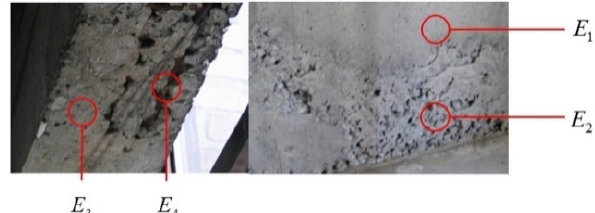
ff erent elastic modulus in di ff erent positions due to material Figure 1. Different elastic modulus in different positions due to material heterogeneity. Figure 1. Di